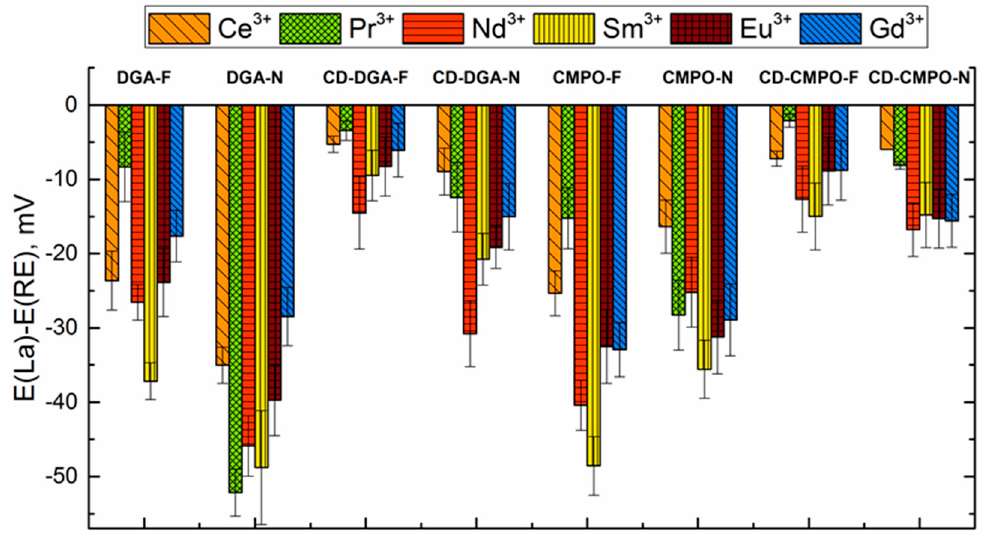
Figure 6. Biionic potentials in solutions of REEs for sensors with ligands covalently bonded to the CD and for sensors with equimolar mixtures of the ligand and CCD.